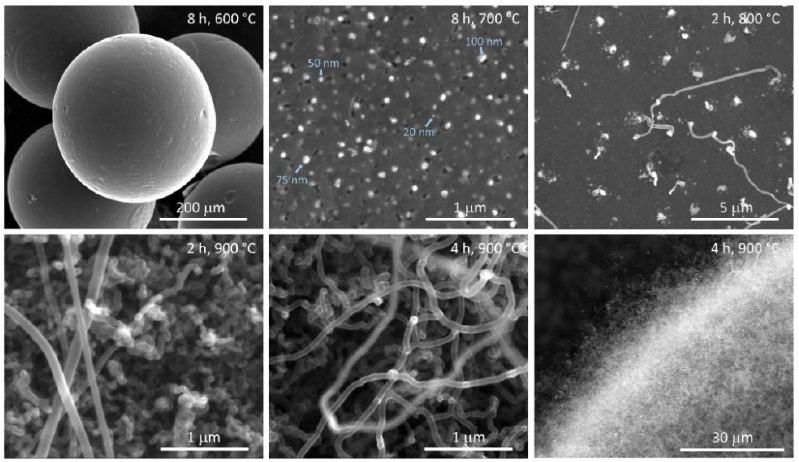
Figure 2. SEM images of Ni-NP/C microspheres (carbonization temperature and time are shown in images).